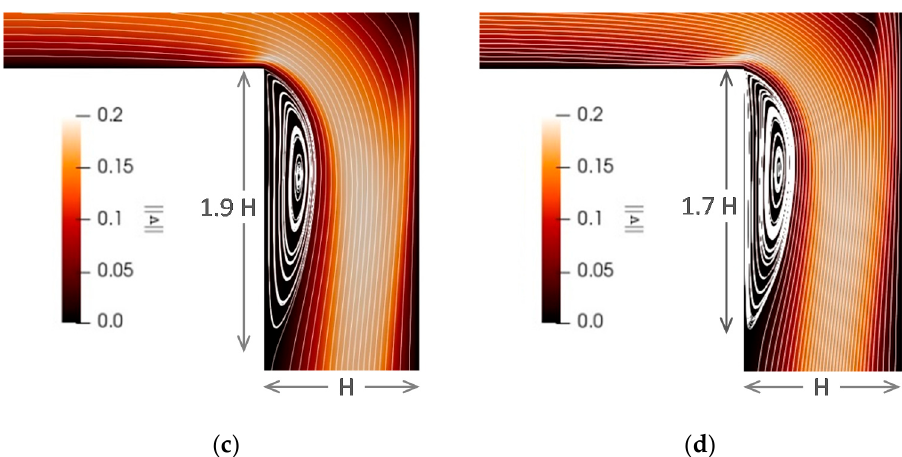
Figure 7. Downstream inertial vortices, Newtonian vs. polymer flow ( β = 0.1.) for Re =100: ( a ) Newtonian flow; ( b ) polymer flow, (Wi = 0.5, El = 0.005); ( c ) polymer flow, (Wi = 1.0, El = 0.01); ( d ) polymer flow, (Wi = 1.5, El = 0.015).